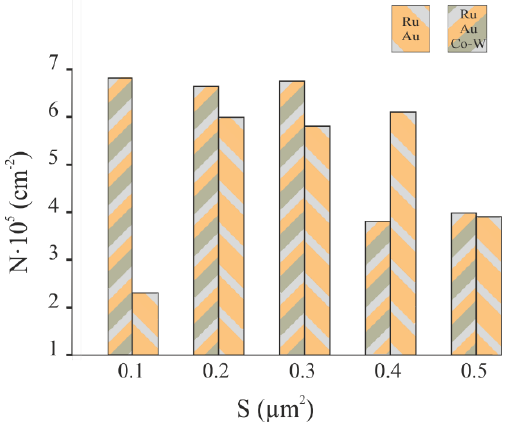
Figure 7. Statistical distribution of the pore’s density versus their area for two types of coatings.